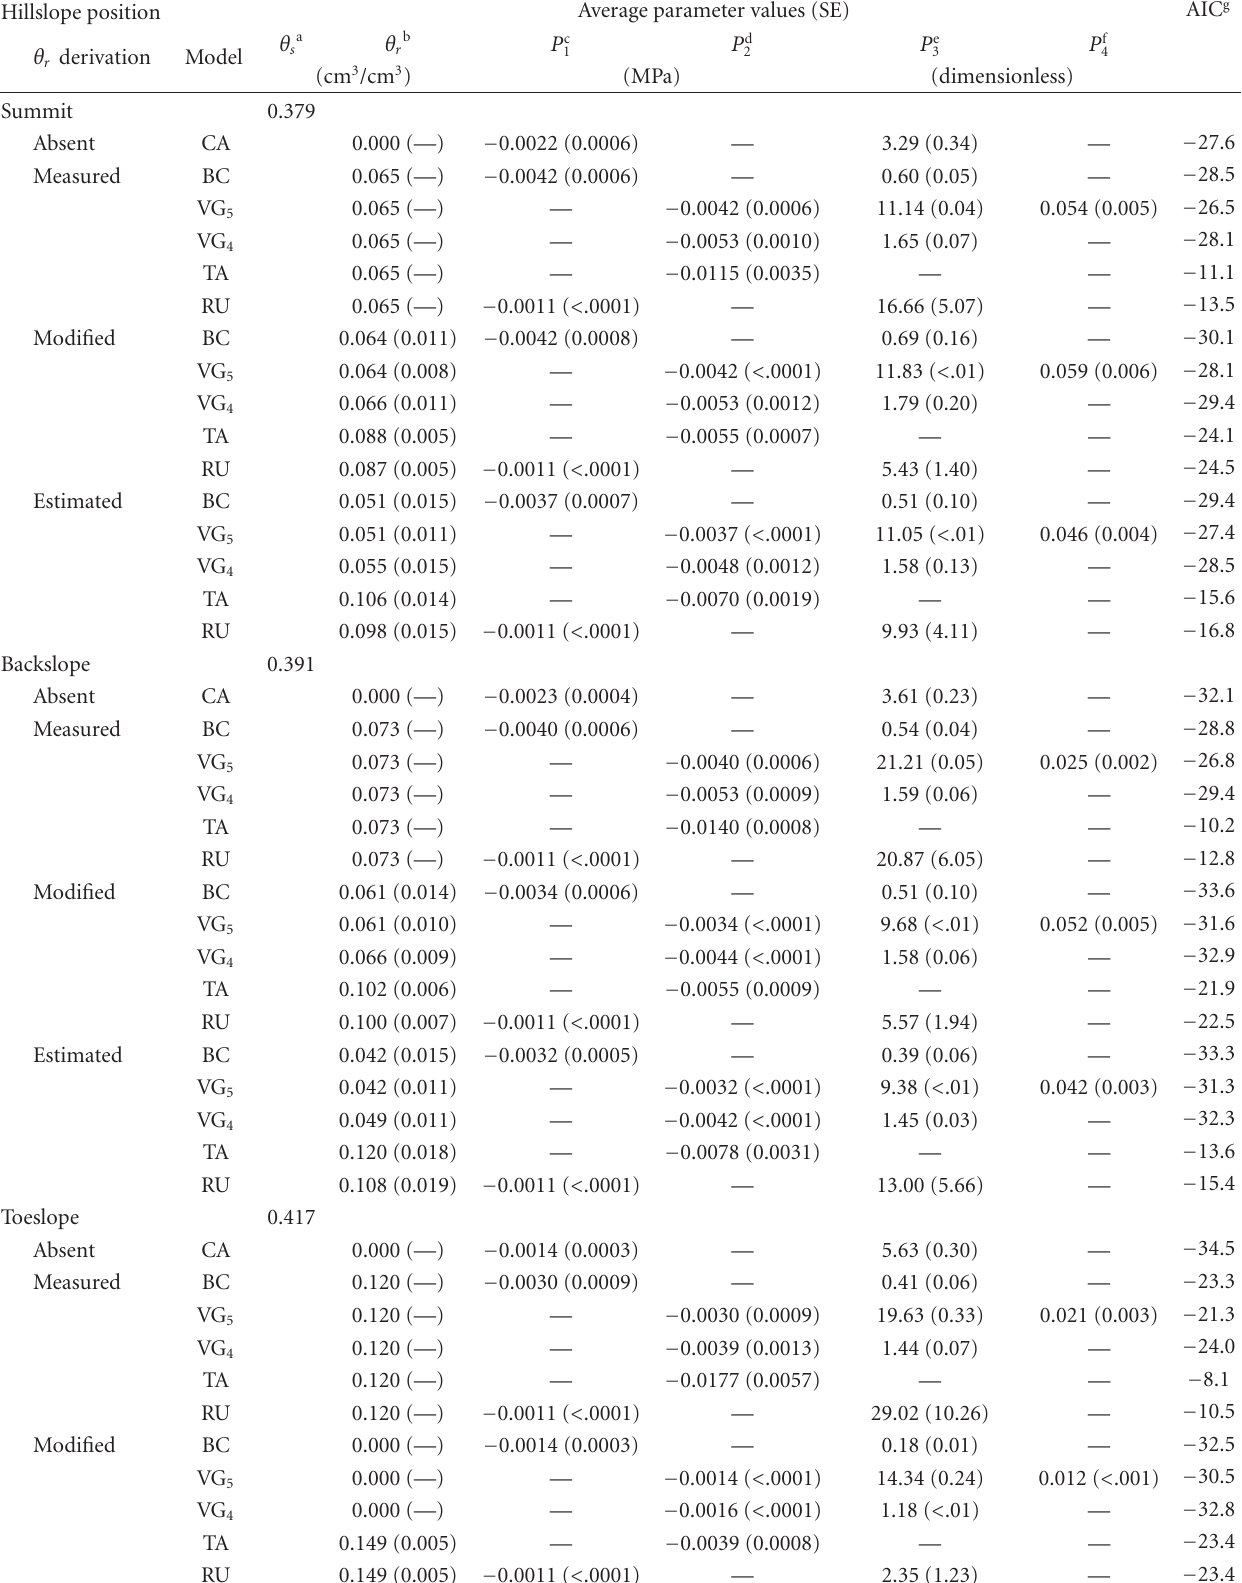
Table 2: Average fitted parameter and AIC values for the soil water retention models across hillslopes. Hillslope